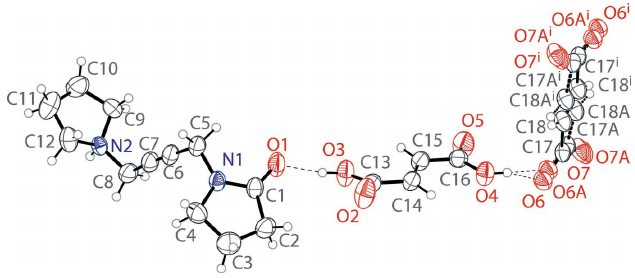
Figure 1 The molecular structure of the title compound showing the atomic labeling. Displacement ellipsoids are drawn at the 50% probability level. Hydrogen bonds are shown as dashed lines. The asymmetric unit contains one half of a fumarate dianion, which is disordered over two positions. The other half of the inversion-generated fumarate dianion is shown. Symmetry code: (i) 2 (cid:3) x , 1 (cid:3) y , (cid:3) z